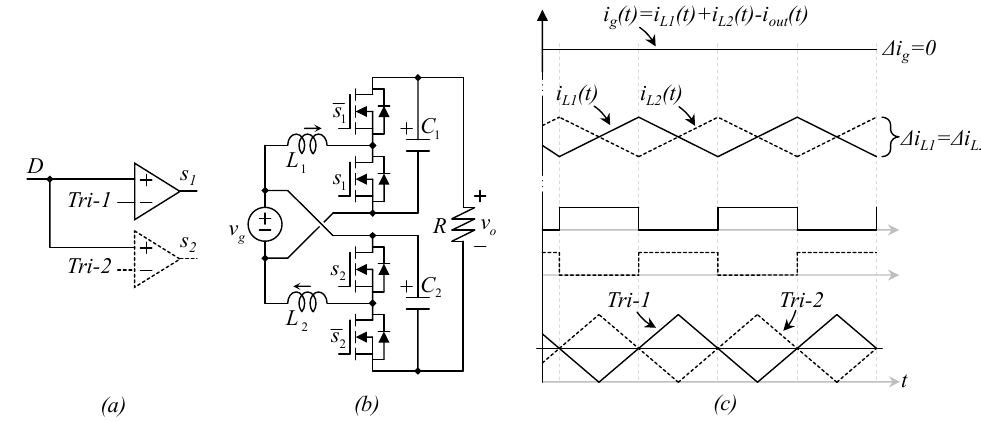
Figure 7. The DDBC during the zero-input current-ripple, ( a ) PWM block diagram, ( b ) circuit schematic, and ( c ) important waveforms of the PWM strategy and the circuit operation.